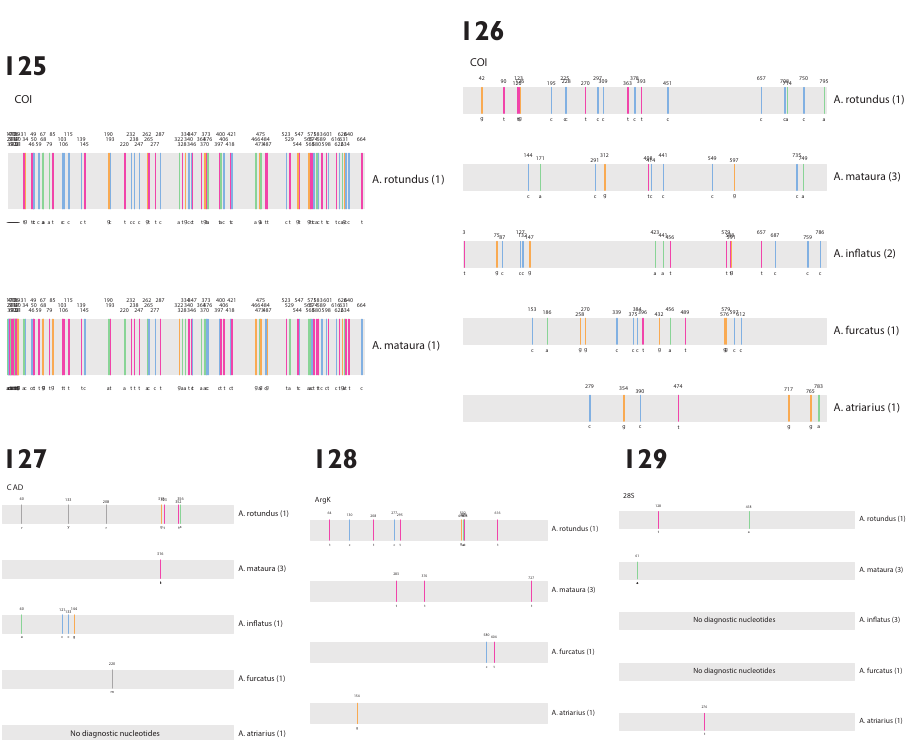
Figures 125–129. Diagnostic nucleotides within the Austromonticola specimens sampled. Numbers above the bars indicate the position of the diagnostic base within the alignment. Numbers in parentheses beside species names indicate the numbers of specimens included in the alignment. Letters below the bars and the colour of the vertical bar indicate the value of the diagnostic nucleotide. 125 the 5 ' (“barcod- ing”) region of the COI mitochondrial protein-coding gene 126 the 3 ' region of COI 127 CAD nuclear protein-coding gene 128 ArgK nuclear protein-coding gene 129 28S nuclear ribosomal RNA